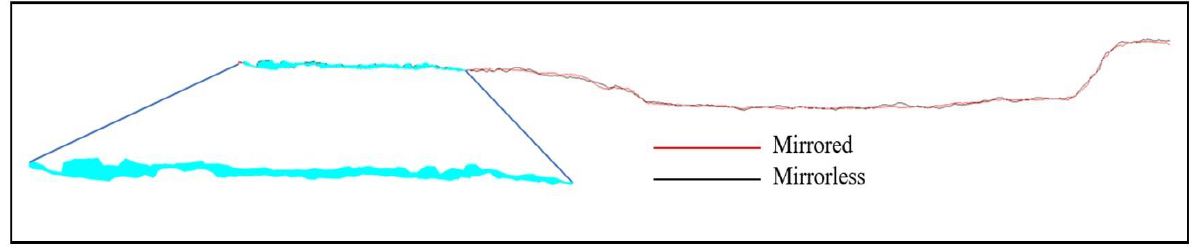
Figure 6. Section 2 of mirrored Nikon D700 and mirrorless Sony a6000 in the direction of control points 2-4-6-8-10 and maximum area difference between them Cross Section